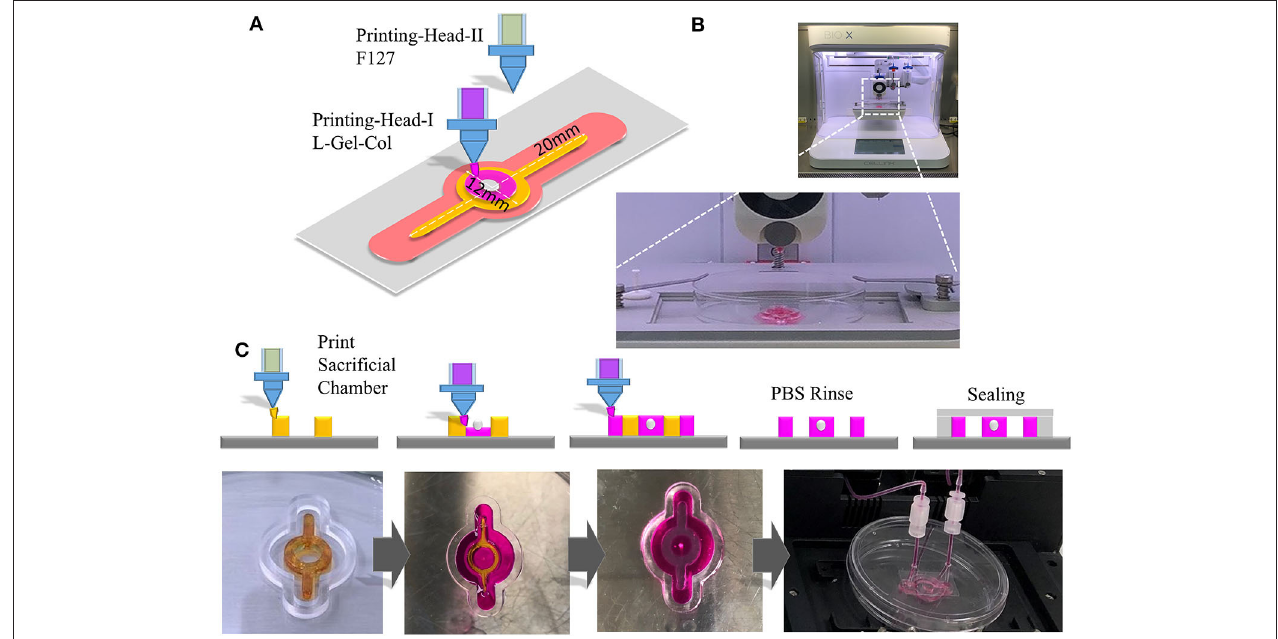
FIGURE 5 | 3D Printing with composite hydrogel and fabrication of cancer spheroid containing Tumor-on-a-Chip. (A) Schematic illustration of 3D printing of a cancer spheroid containing flow chamber for cancer invasion and metastasis study. (B) Chip in 3D printing with BioX bio-printer (CellInk). (C) Upper panels are the schematic illustrate of the processing of the flow chip. Chip was first printed with F127 as a sacrificial layer. Then the L-G-C was printed and photo-crosslinked in the center of chip with cancer spheroids embedded, and the outer layer of the chip. The F127 layer was dissolved with phosphate buffer forming hollow channels for perfusion and the glass sealing was performed. Lower panels are the actual photo for the printed chip at each